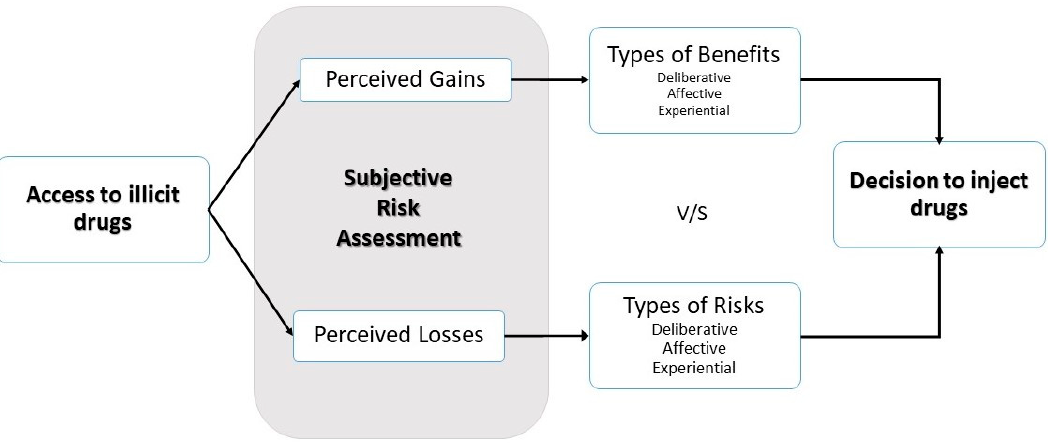
Figure 1. Weighting the perceived gains vs. losses of injecting drug use: a behavioural economic